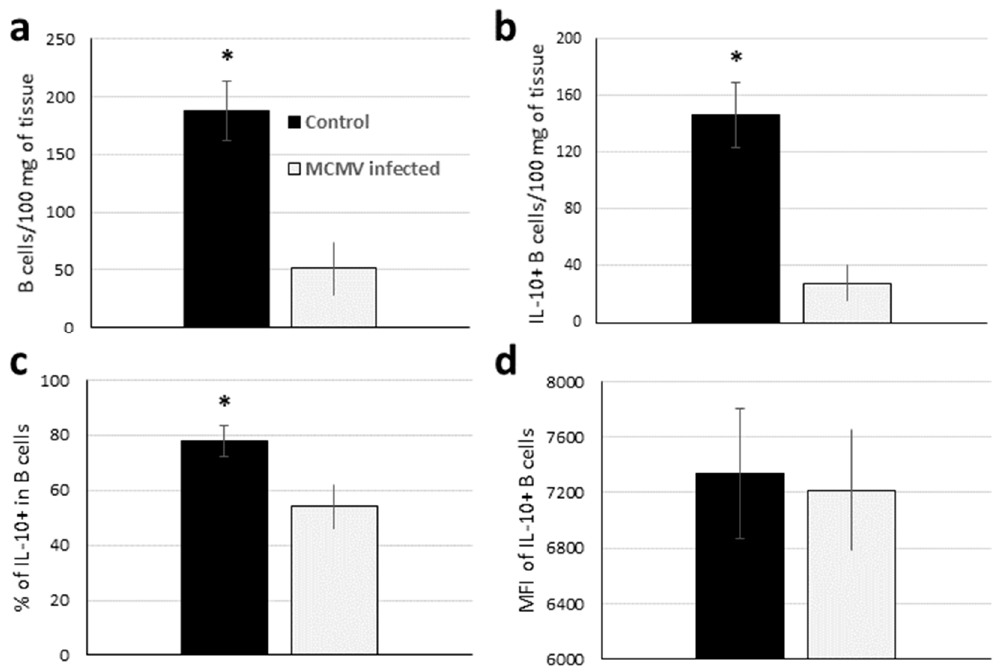
Figure 6. Regulatory B-cell number decreases in GWAT upon infection with MCMV. ( a ) Tissue weight-normalized number of viable B-cells (B220 + CD3e − ) in the SVF from uninfected (black column) or MCMV-infected (grey) in 3-day GWAT cultures (as in Figure 5). ( b ) Tissue weight-normalized number of viable IL-10 + B-cells (Bregs) in the same tissues. ( c ) Percentage of IL-10 cells among viable B-cells. ( d ) Median fluorescence intensity associated with intracellular IL-10 production in IL-10 + B-cells. Columns and error bars denote average and standard deviation ( n = 4). * p < 0.05 according to two tail t